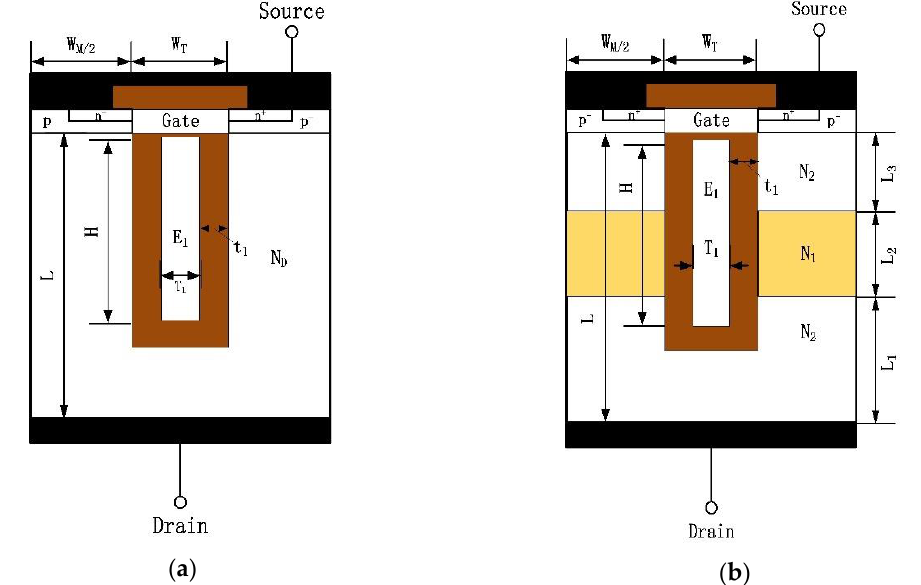
Figure 1. Cross section view of ( a ) split-gate resurf stepped oxide (SGRSO) and ( b ) split-gate resurf stepped oxide with high doped epitaxial layer (HDSGRSO) u-shape metal oxide semiconductor field effect transistor (UMOSFET).